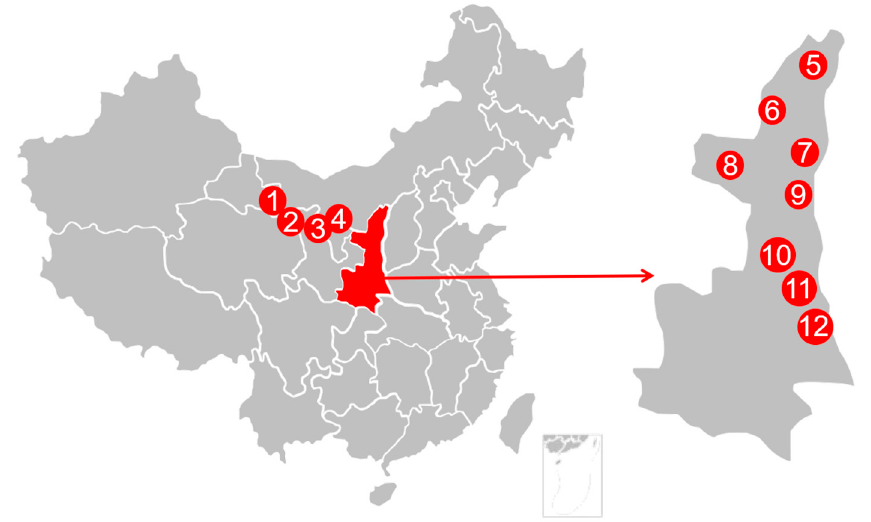
Figure 6. Geographical data for AFH’s sampling locations.